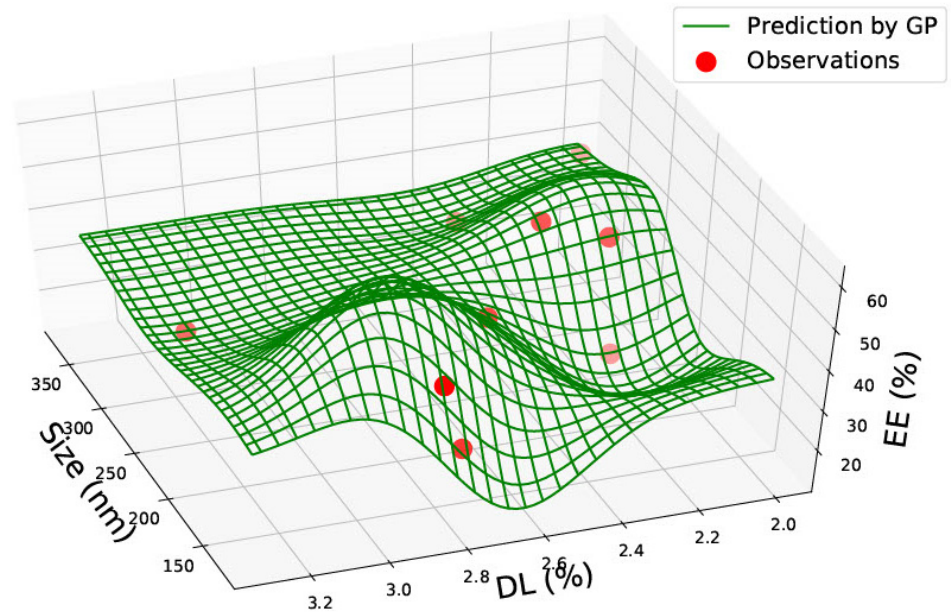
Figure 6. PLGA 65:35—graph with size (nm), Drug Load (DL%) and Encapsulation Efficiency (EE%). Figure 4 represents graphs with size, PDI and drug load. Similar to PLGA 50:50,